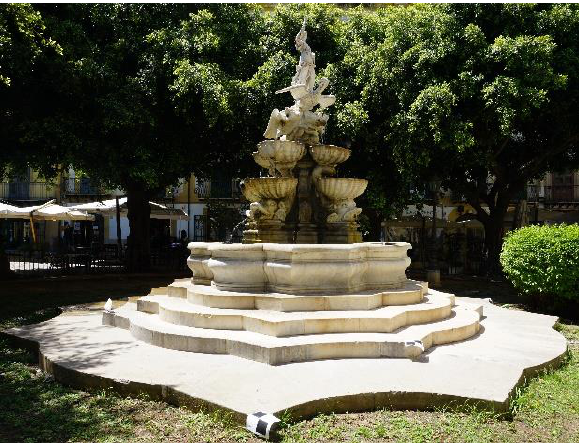
Figure 3. The Garraffo fountain nowadays, located in Piazza Marina.